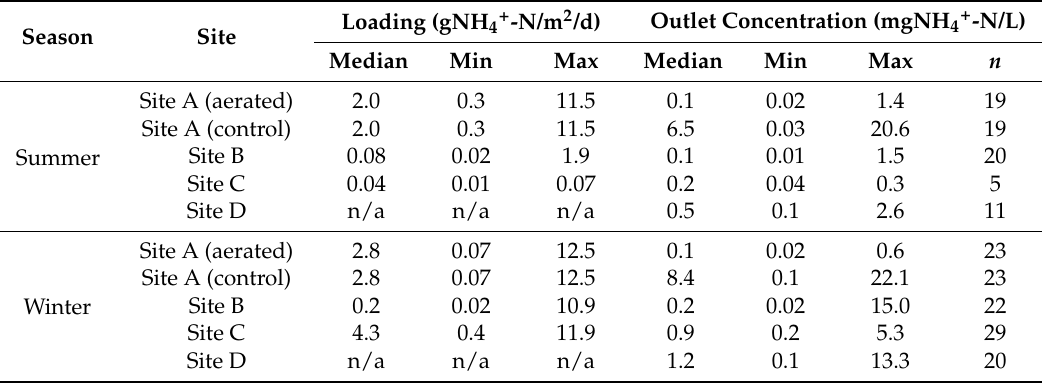
Table 2. Summer and winter ammonium inlet loadings and effluent